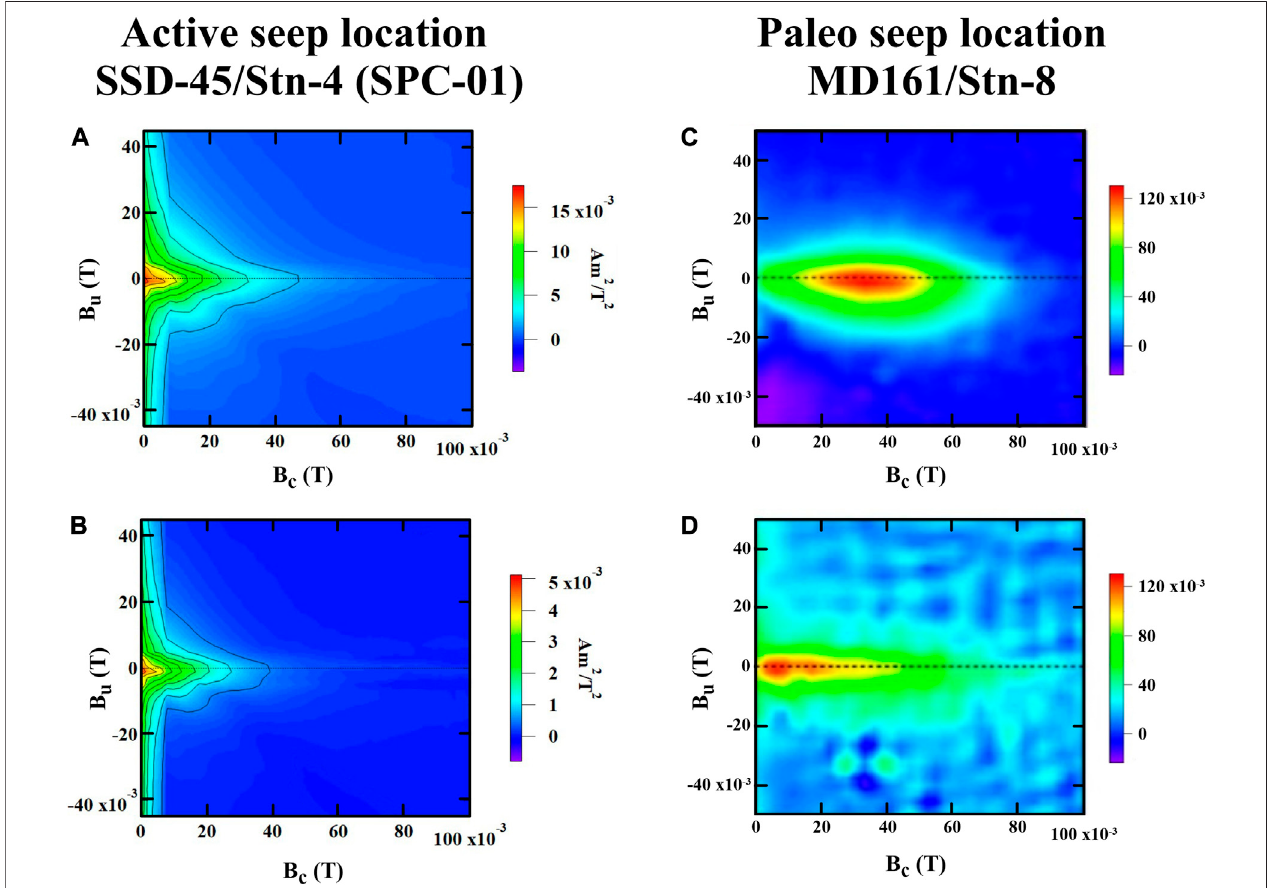
FIGURE 12 | Comparative FORC diagrams of greigite bearing sediment intervals from (A,B) : active (SSD-45/Stn-4/SPC-01) and (C,D) of paleo-seep location (MD161-Station-08; modi fi ed from Badesab et al., 2020a) in the Krishna-Godavari (K-G) basin, Bay of Bengal. The dashed (black) lines along Bc axis highlights the negative region on the horizontal